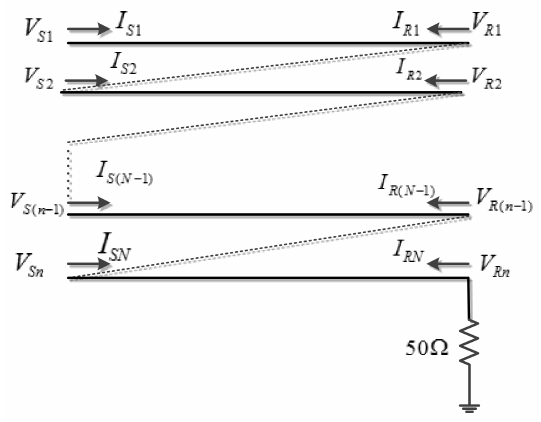
Figure 2. Multi-conductor transmission line model.